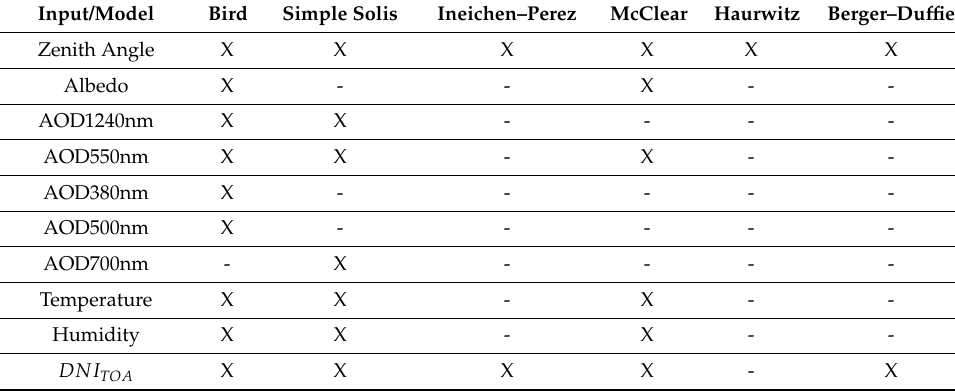
Table 1. Model and input parameters required.